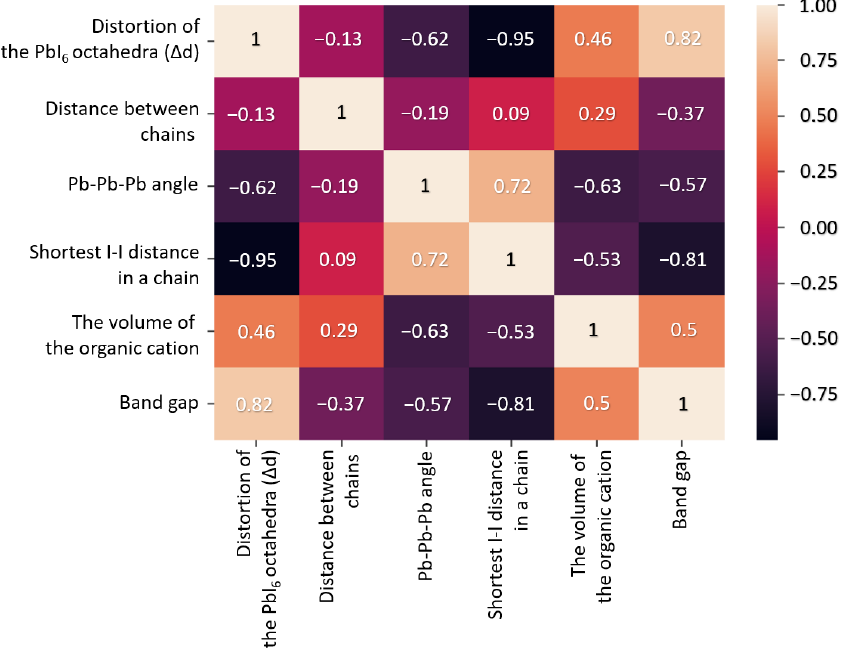
Figure 5. Heatmap of Pearson correlation coefficient matrix for geometrical descriptors and the band gaps of 1D perovskite-derived experimental structures with vertex-connected chains of PbI 6 octahe- dra.